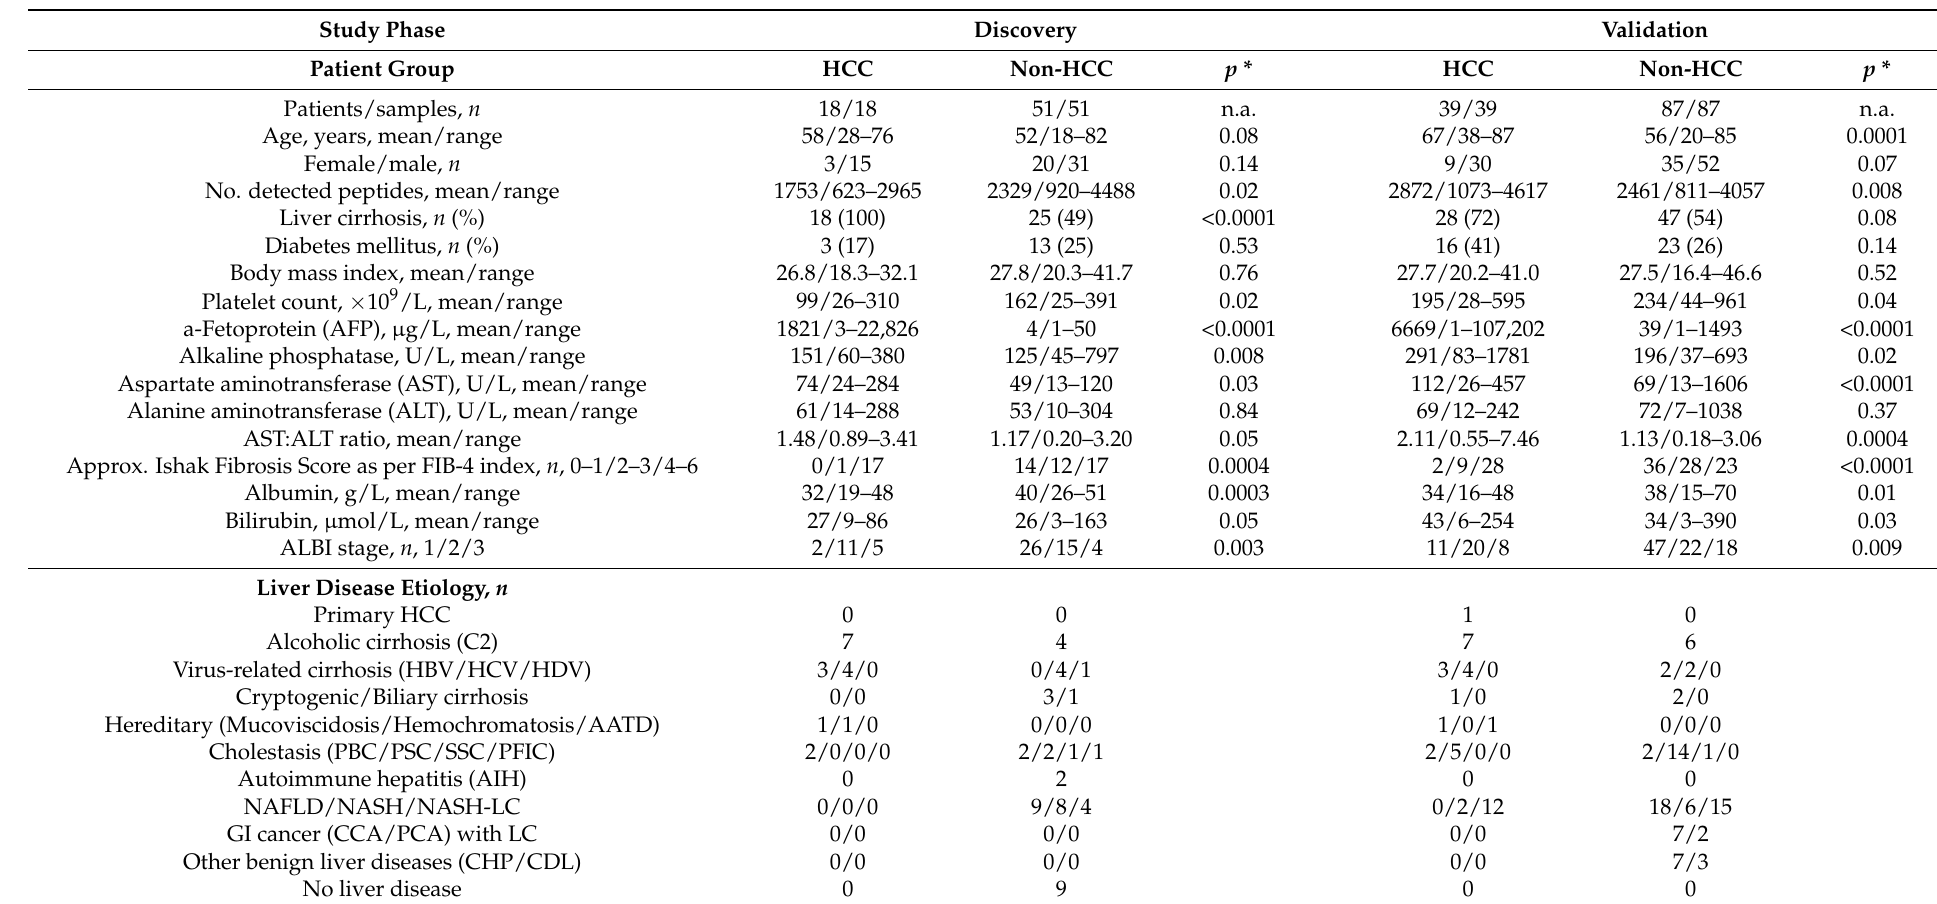
Table 1. Clinical and demographic data of HCC case and non-HCC control patients included in the discovery and validation phase of the study. Parameters, demonstrating significant differences between the HCC and non-HCC groups, were further investigated using one-way ANOVA on subgroups of patients with NAFLD ( n = 27), NASH without LC ( n = 14), LC ( n = 72) and HCC ( n = 57). The respective Box-and-Whisker distribution plots are presented in Supplementary Figure